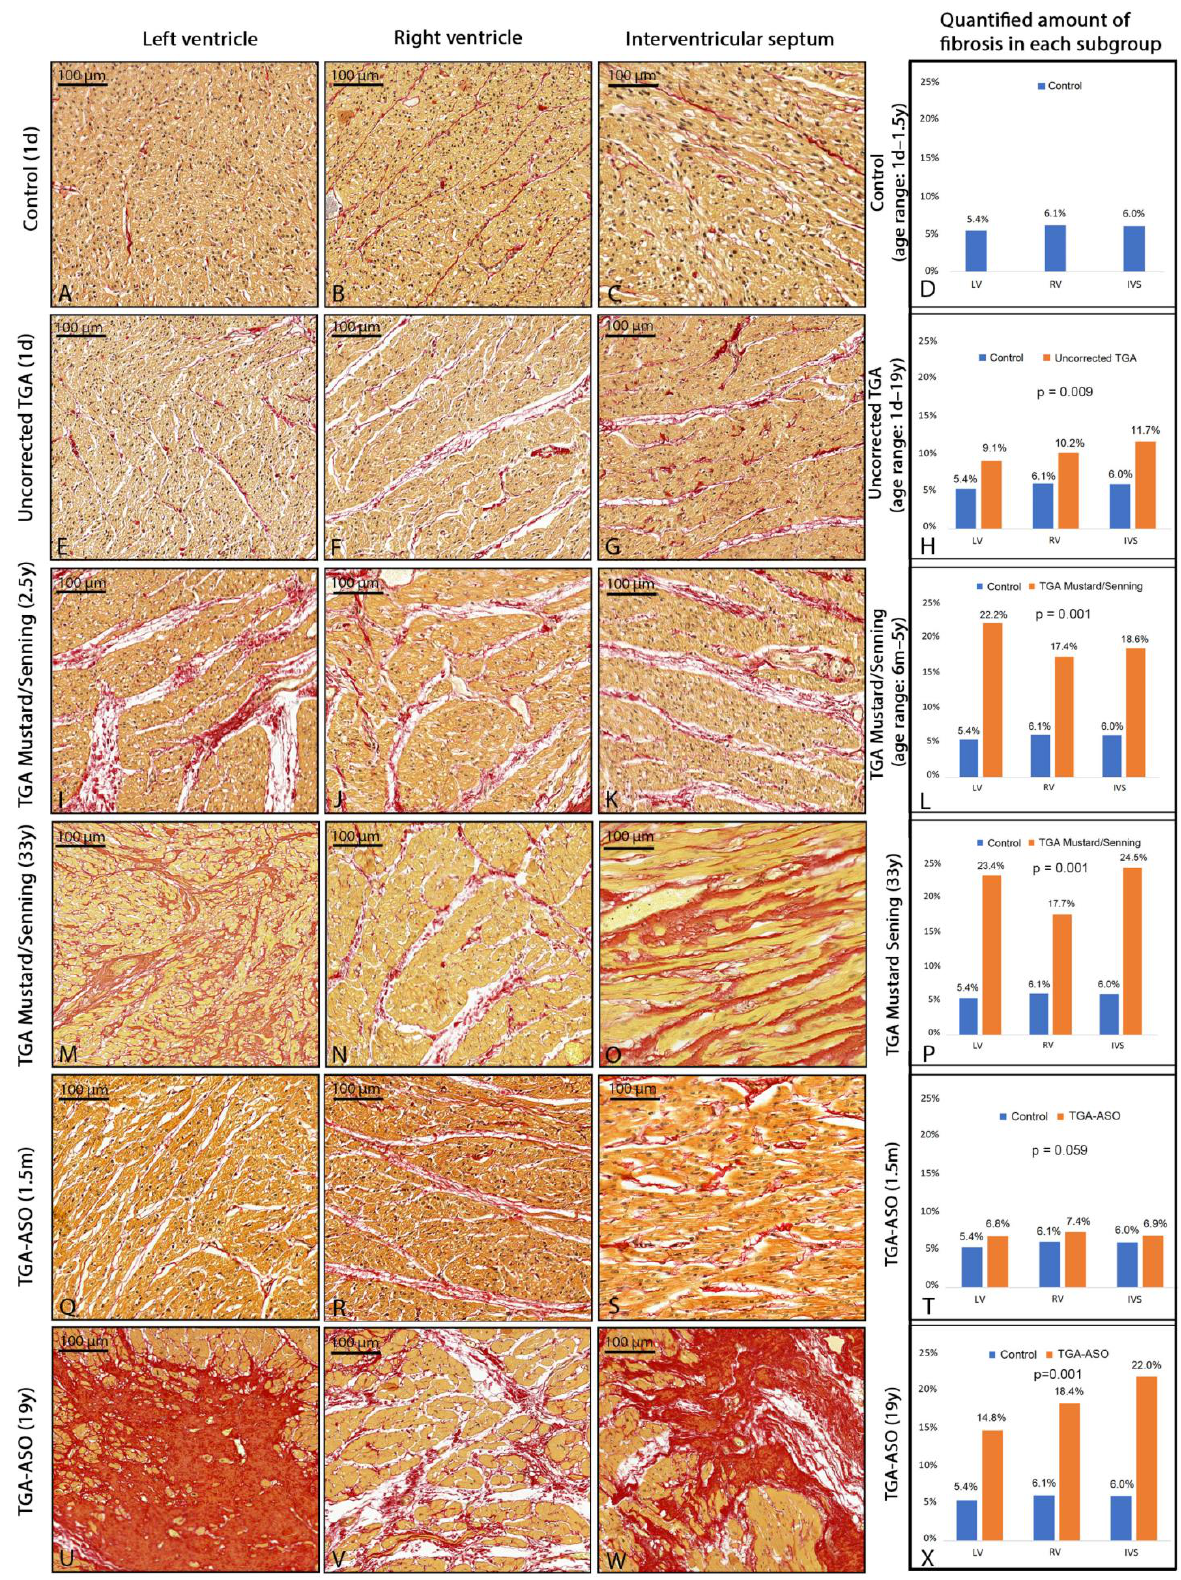
Figure 4. Patterns and amount of fibrosis in control, uncorrected TGA, TGA-Mustard/Senning, and TGA-ASO specimens. Fibrosis patterns and quantification in postmortem hearts (Sirius red staining). Normal myocardium at 1 day ( A – C ) and mean reference values in 3 control hearts without